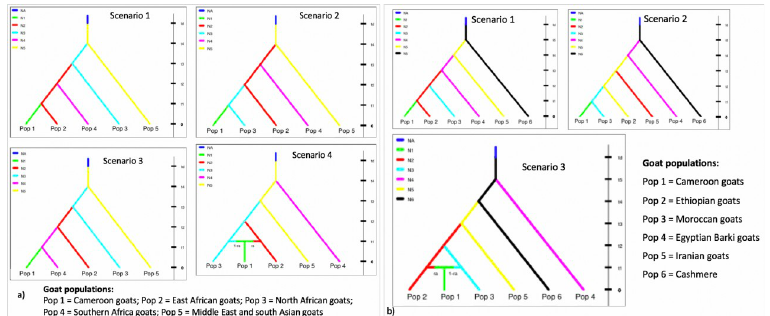
Fig 1. Regional representation of goat populations to infer the historical gene flow towards Cameroon examined using Approximate Bayesian Computation implemented in DIYABC. a) Based on mtDNA, Cameroon goats were descended either from east Africa (scenario 1), north Africa (scenario 2), southern Africa (scenario 3) or east and north Africa (scenario 4). b) Based on autosomal SNP markers, Cameroon goats were descended either from east Africa (Ethiopia; scenario 1), north Africa (Morocco; scenario 2) or east (Ethiopia) and north (Morocco) Africa (scenario 3).